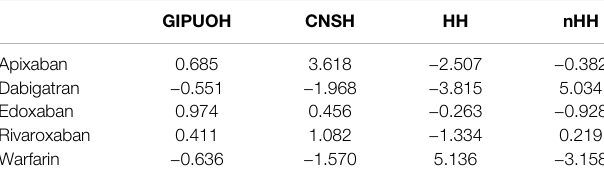
TABLE 4 | Individual contribution to the Pearson χ 2 statistic.